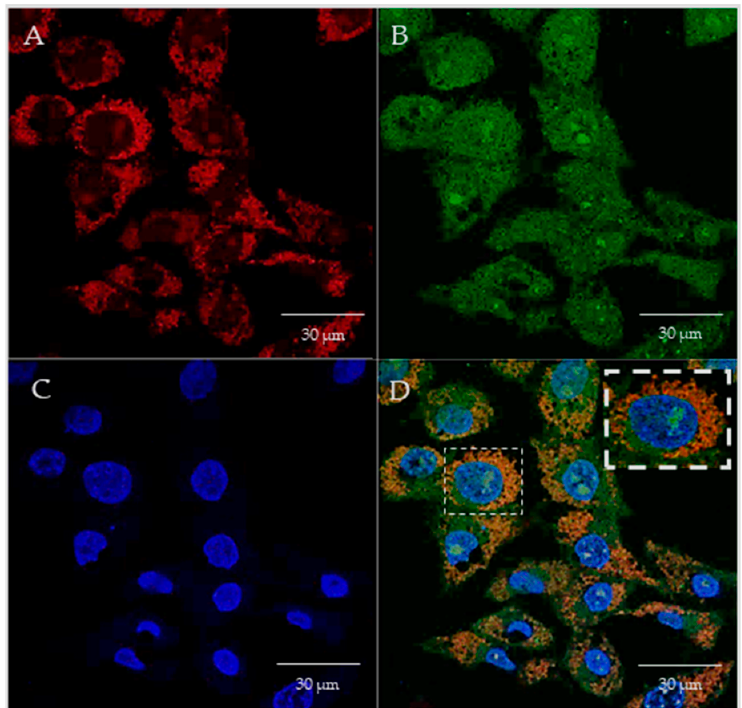
Figure 10. Cellular uptake and intracellular colocalization of PEI–DQA (10 kDa)/TAT/pND1 com- plexes formulated at an N/P ratio of 50:2:1. Mitochondria stained red by MitoTracker ( A ), green labeled pND1 ( B ), nuclei marked blue by DAPI ( C ), and merged image ( D ).